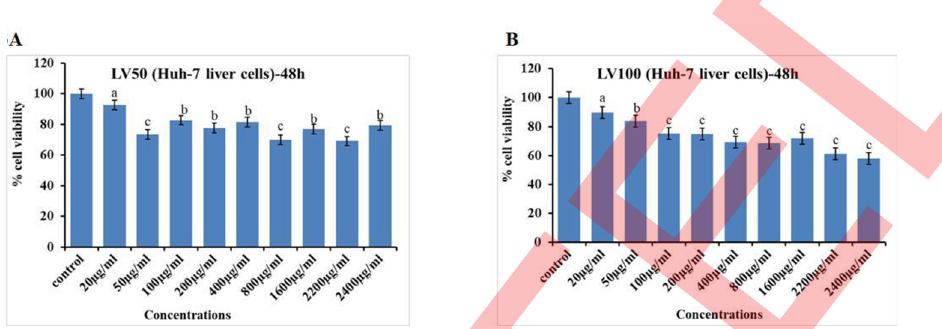
Fig 3. Cell viability in Huh-7 liver cells treated with methanol extracts of Lavandula angustifolia 50% (3A) and 100% concentration (3B) at 48 h after incubation. The data are presented as means ± SE of four different experiments. The means which do not share a common letters differ significantly from control.